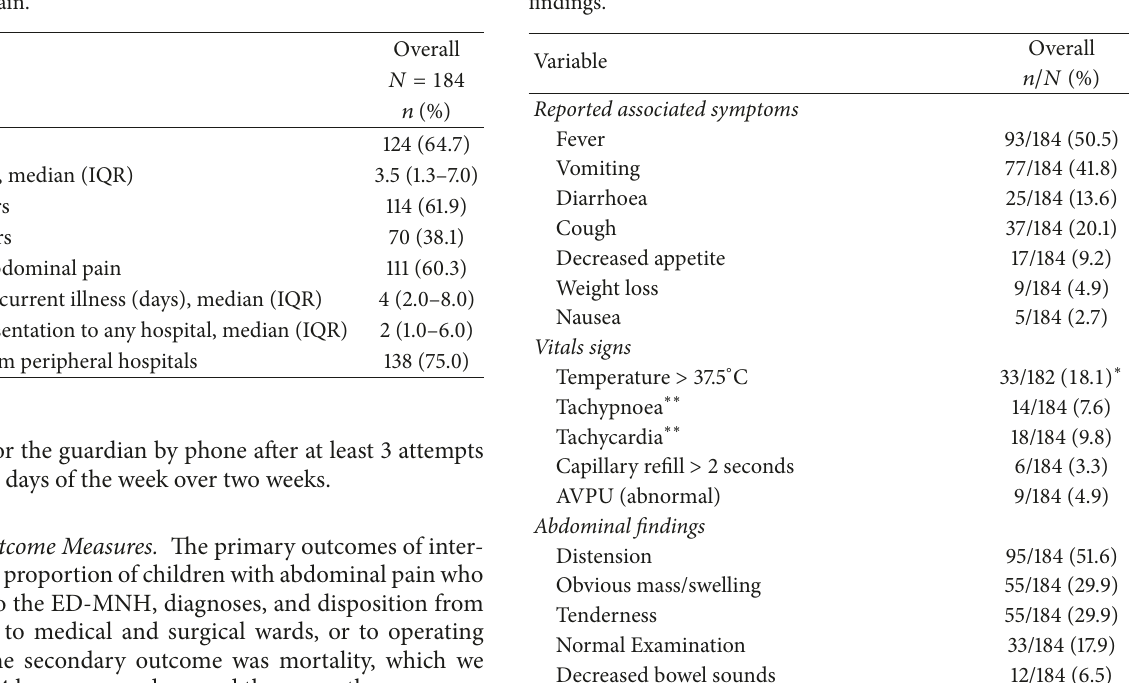
Table 1: Demographic characteristics of children presenting with abdominal pain.